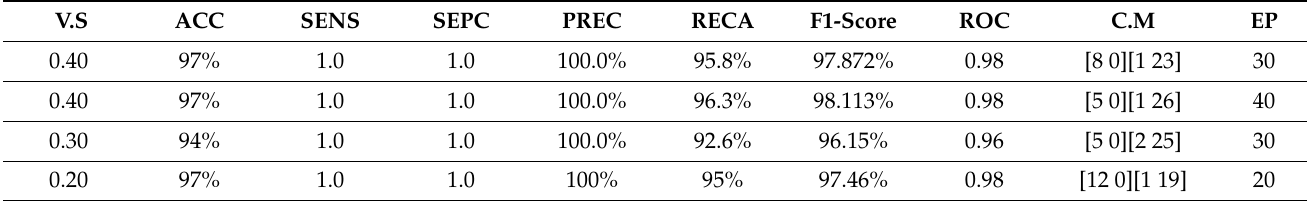
Table 1. Adam’s rate of learning is =0.001. The loss function is categorical cross entropy (CCE).